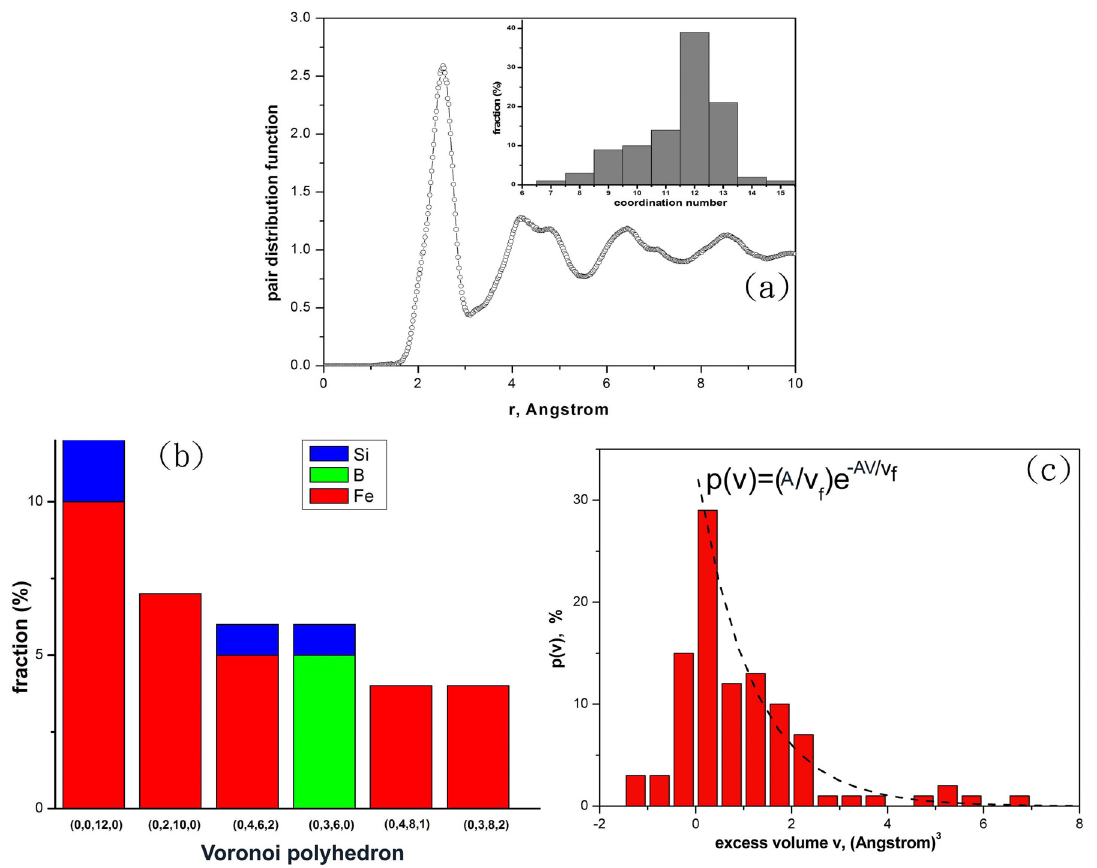
Figure 1. Analyses on the structural properties of Fe-Si-B glassy alloy at ambient pressure. ( a ) Pair distribution function. The inset is the histogram of atomic coordination numbers. ( b ) Fraction of Voronoi polyhedrons. ( c ) Histogram of excess volumes v . The dash curves are the fits for histogram of v >